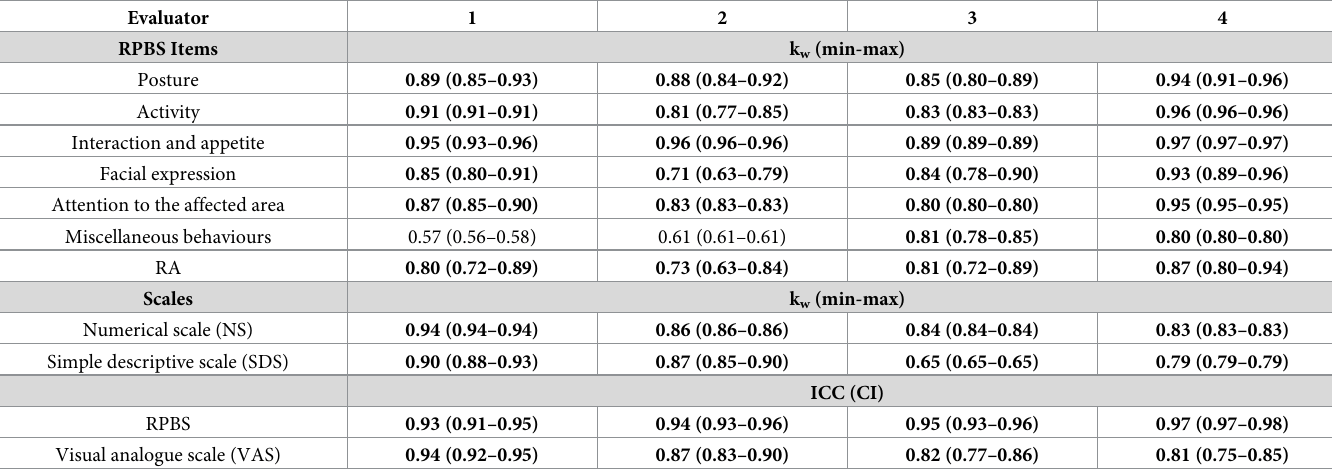
Table 6. Intra-observer reliability of RPBS, unidimensional scales, and rescue analgesia indication in rabbits. Evaluator